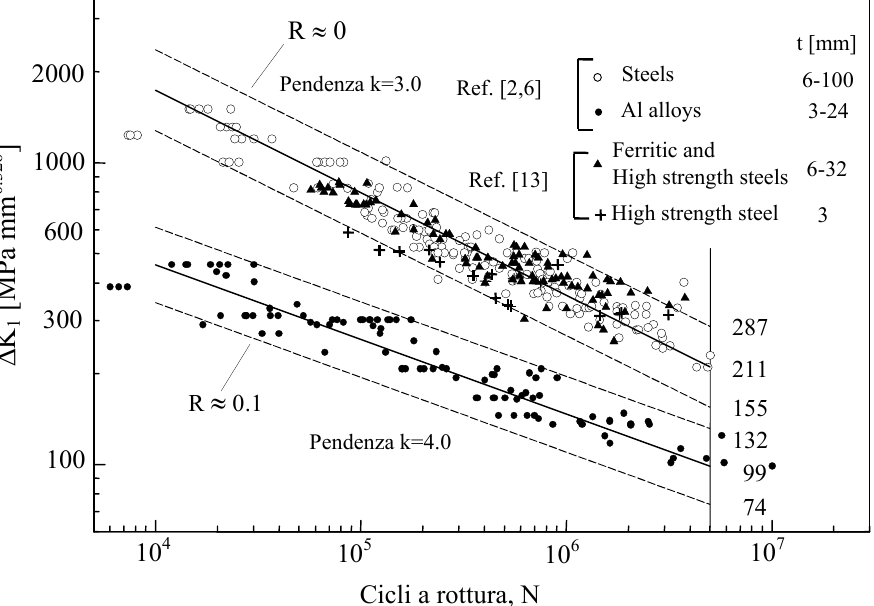
Figura 1. Resistenza a fatica di giunti saldati in acciaio e lega leggera in funzione del fattore di intensificazione delle tensioni di modo I. Geometrie a croce e a T, con cordone portante. Angolo di apertura di 135°; t spessore dei piatti principali; banda di di-